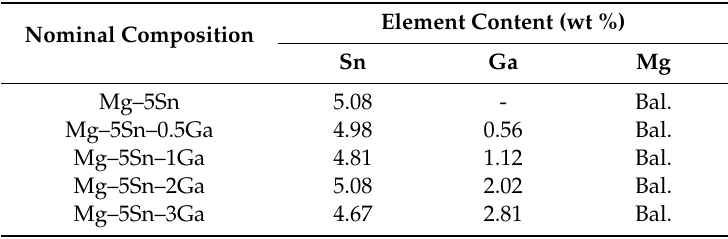
Table 1. Chemical compositions of the experimental Mg–5Sn– x Ga ( x = 0, 0.5, 1, 2, 3 wt %) alloys analyzed by XRF